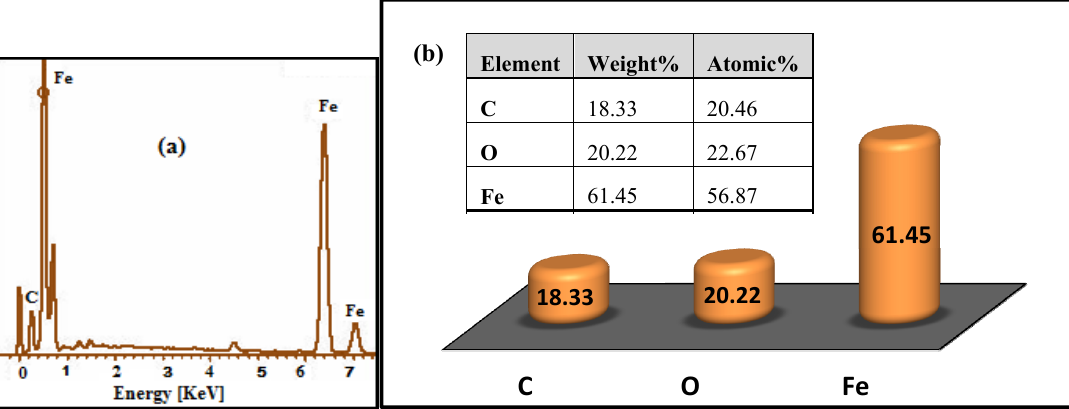
Figure 10. EDX spectra of ( a ) Fe